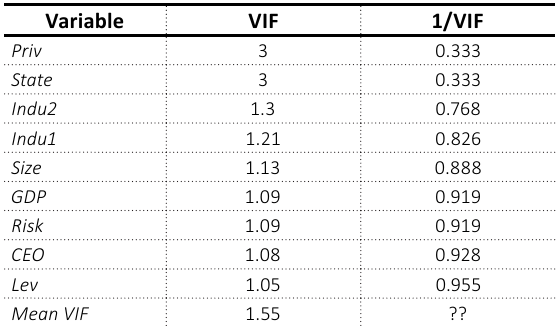
Table 5. Test result for multicollinearity